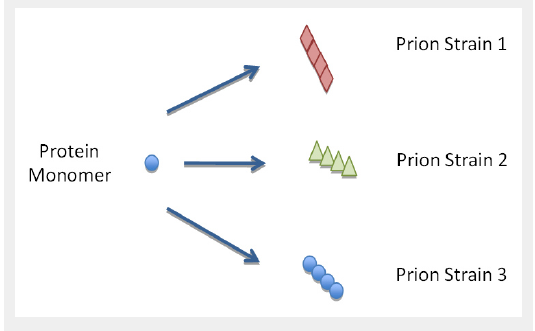
Yeast and mammalian proteins with prion domains have the ability to misfold into a multitude of different conformations that encipher different biochemical and biophysical